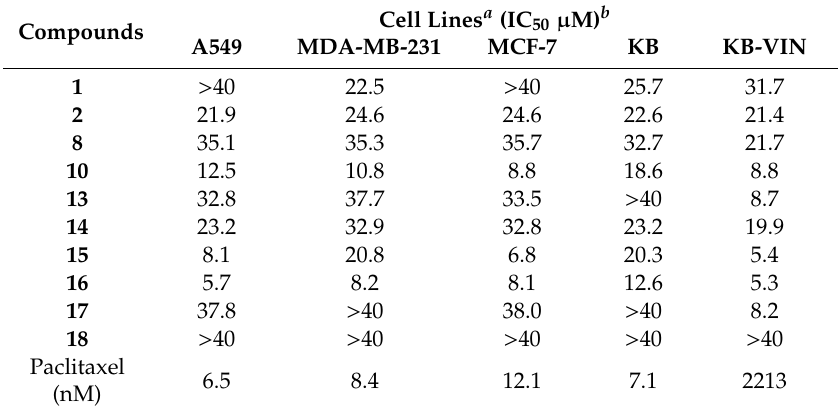
Table 4. Antiproliferative Activity of the Isolated